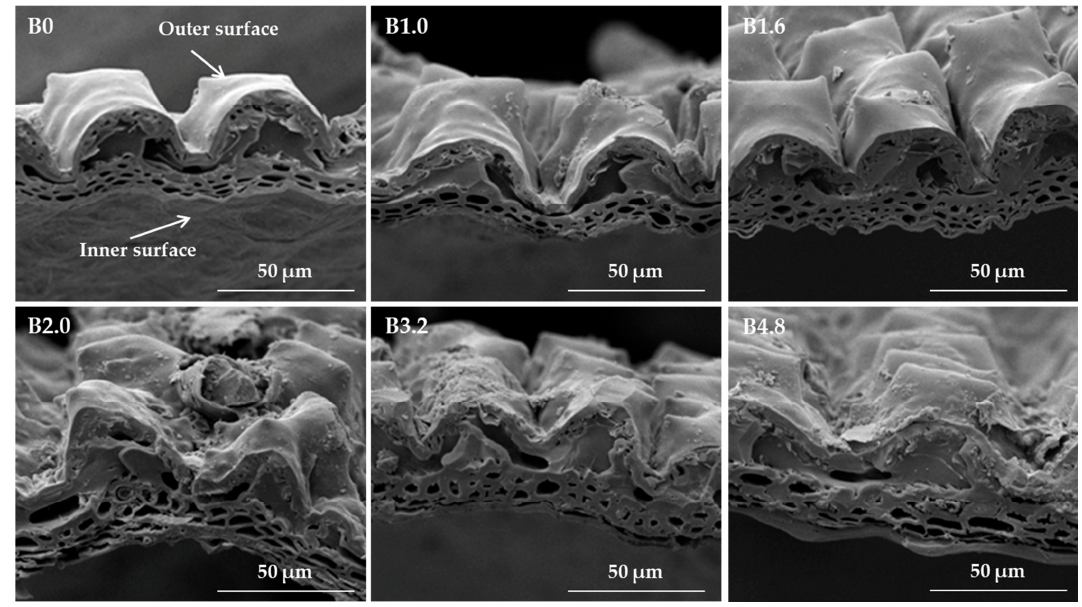
Figure 4. SEM images of biochar obtained from the pyrolysis of rice husks with different boric acid contents. (B0, B1.0, B1.6, B2.0, B3.2, and B4.8 were biochar samples prepared by the pyrolysis of rice